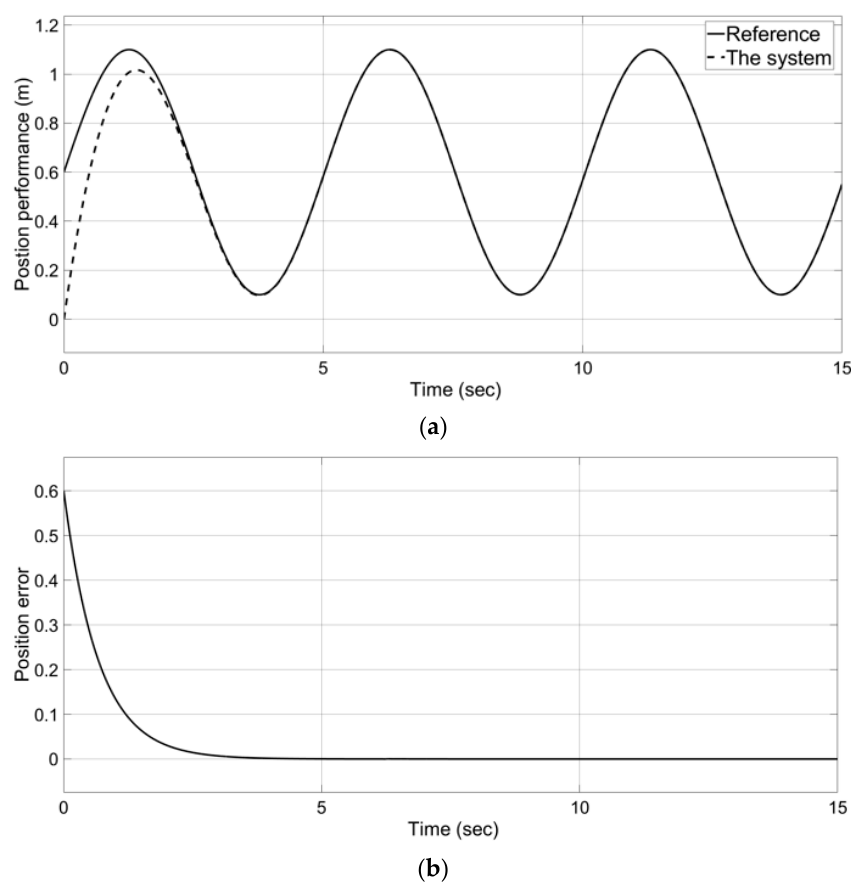
Figure 5. Simulation result of the adaptive sliding mode control scheme: ( a ) results of position performance and ( b ) error in the performance.